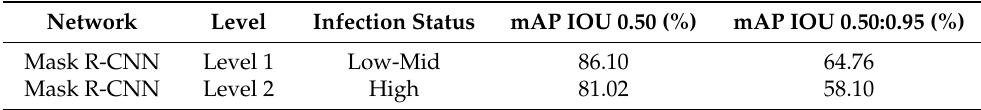
Figure 8. Examples for the diseases present in Level 1 and Level 2 for Anthracnose Fruit Rot and Powdery Mildew Leaf. Table 9. Performance evaluation for variable disease